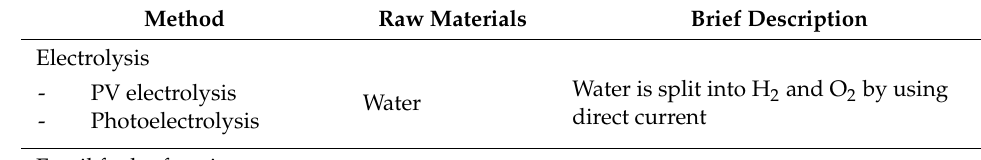
Table 1. Description of various hydrogen production technologies [7].